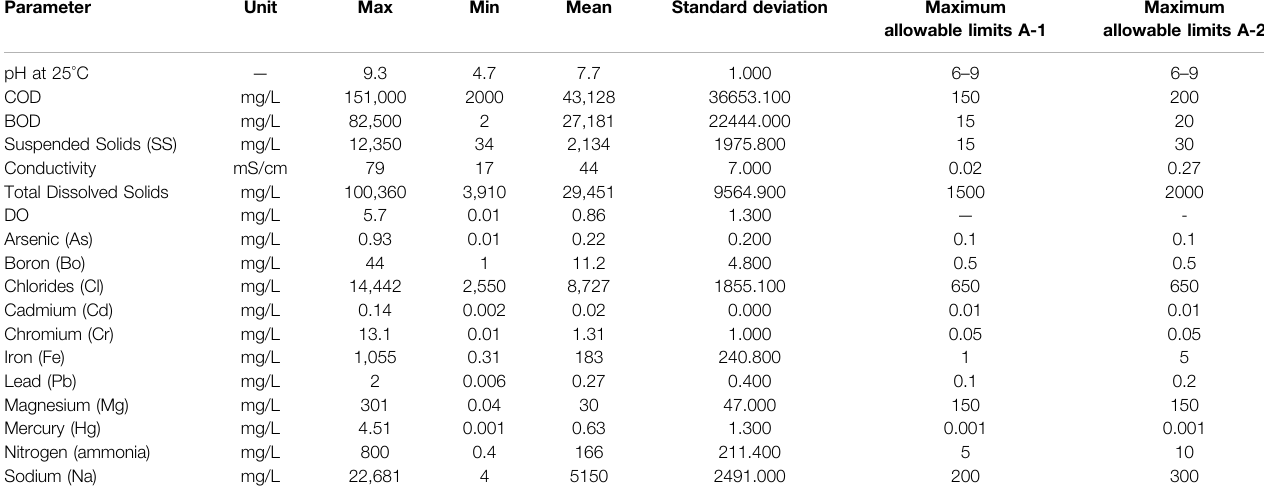
TABLE 2 | Characteristics of raw leachate from Al Amerat engineered sanitary land fi ll, Oman.